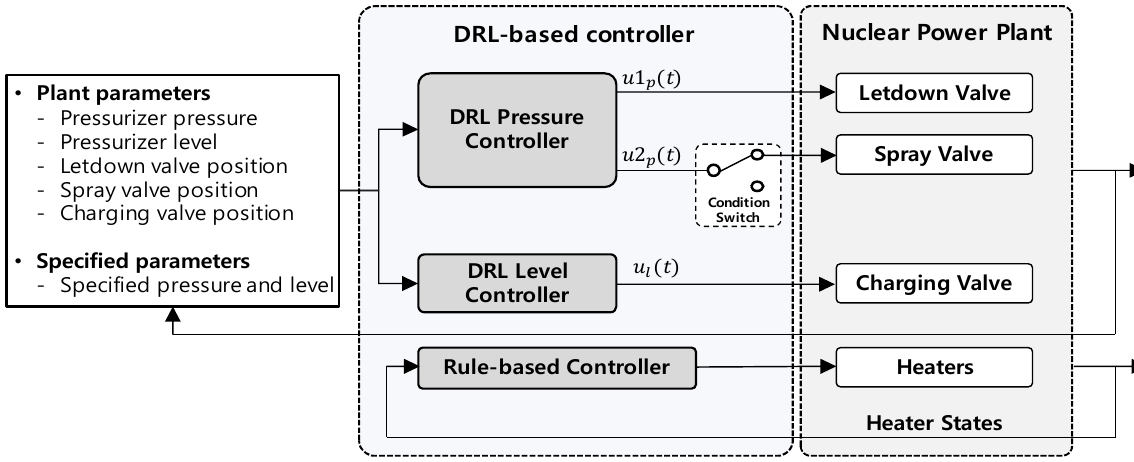
Figure 3. DRL-based controller block diagram. Table 4. Controller tasks for cold shutdown operation.